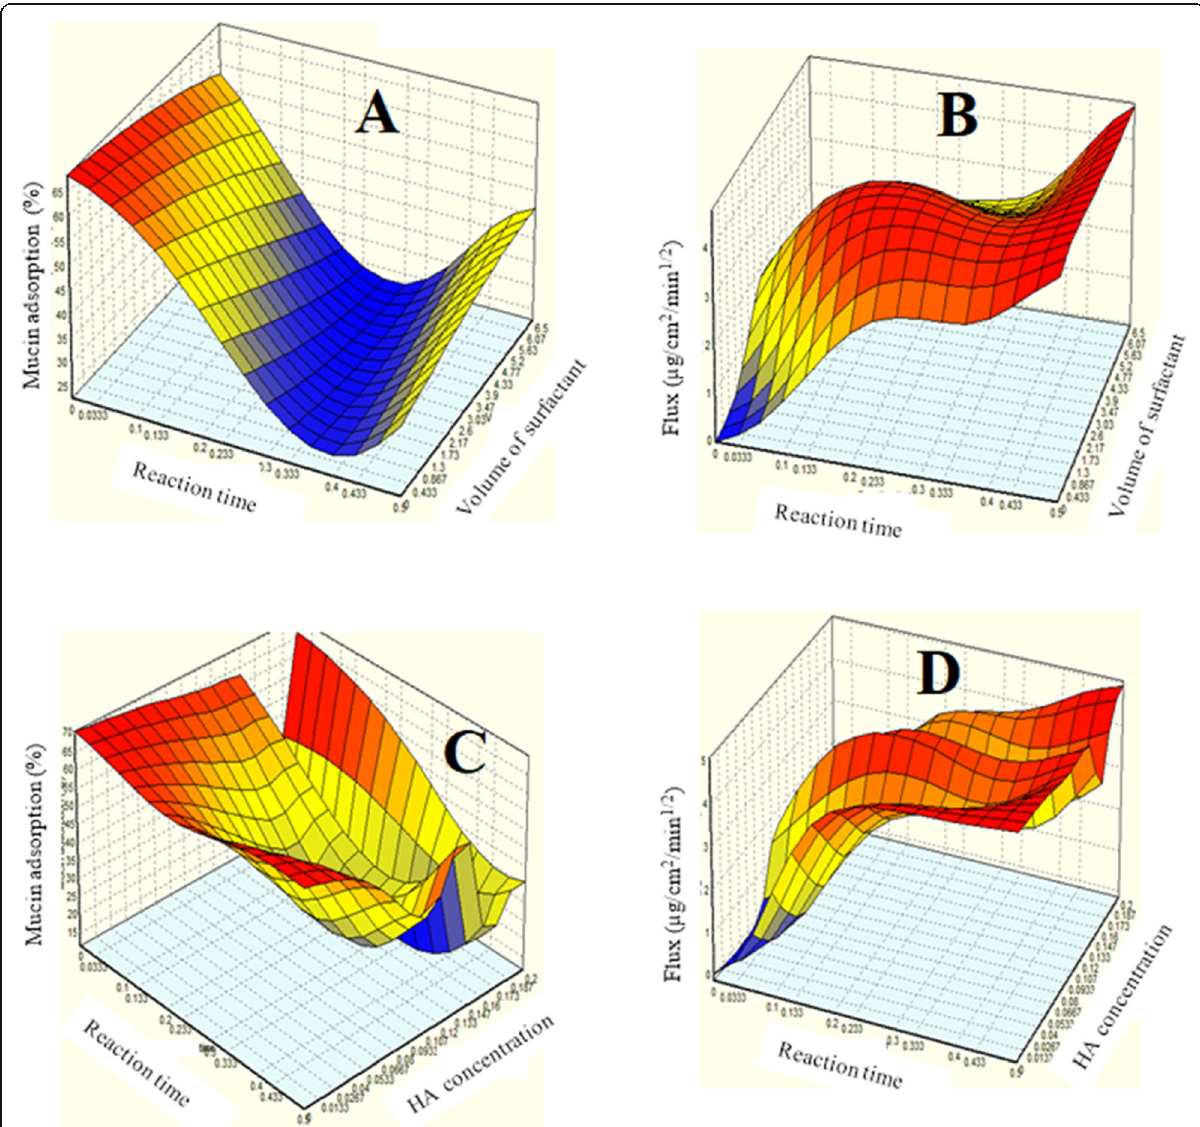
Fig. 2 Showing a response surface plot showing effect of reaction time and volume of surfactant on mucin adsorption. b Response surface plot showing effect of reaction time and volume of surfactant on flux. c Response surface plot showing effect of reaction time and HA concentration on mucin adsorption. d Response surface plot showing effect of reaction time and HA concentration on flux